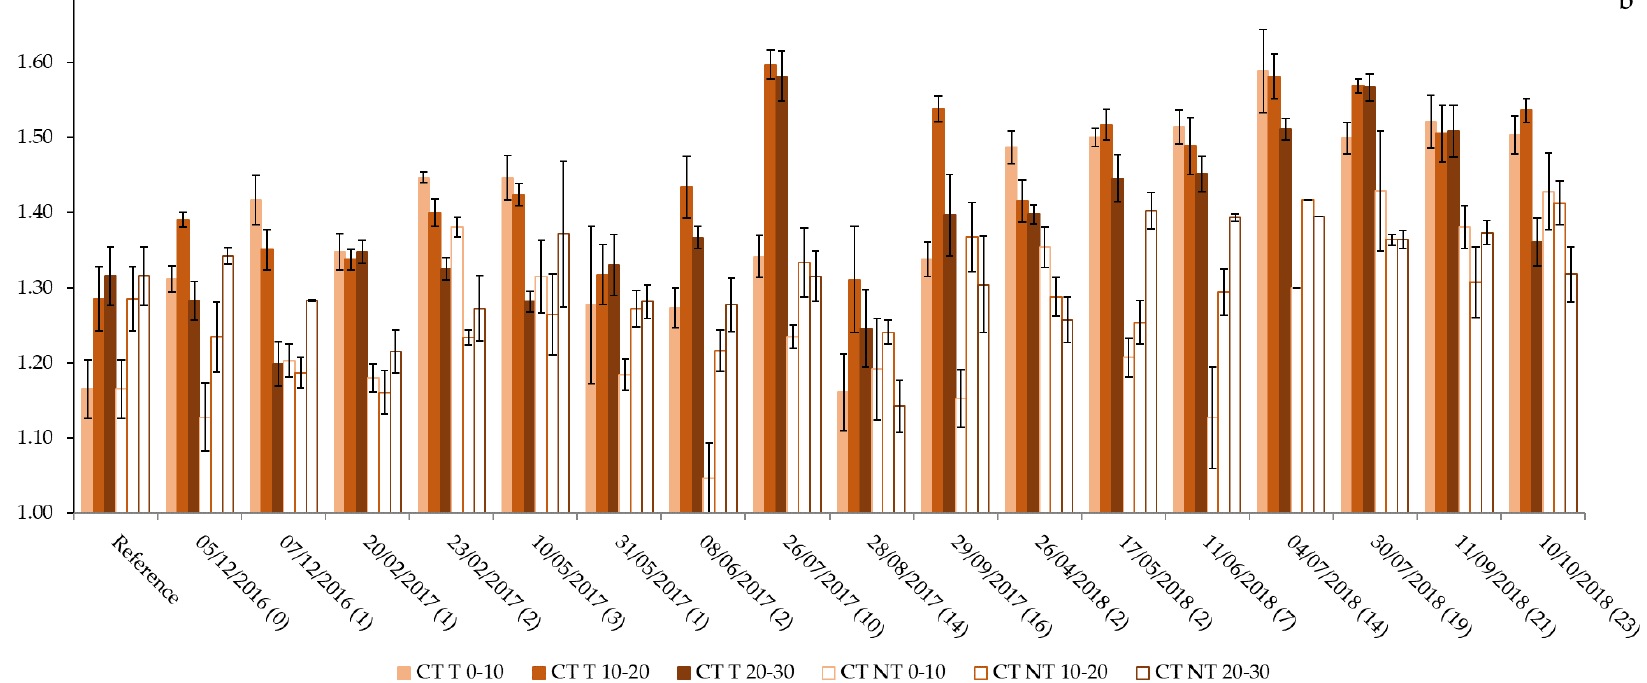
Figure 4. Mean bulk density (BD) (g m − 3 ) measured along the period of observation at three depths in track (T) and no-track (NT) positions in the two vineyard plots (( a ) GC = with grassed inter-rows and ( b ) CT = with tilled inter-rows). The “b” letters indicate significant difference with the corresponding reference values (“a” are omitted), obtained with t-test ( p = 0.05). Number in brackets after the date indicates the number of tractor passages occurred with respect to reference soil conditions (minimum BD for GC and after tillage for CT).